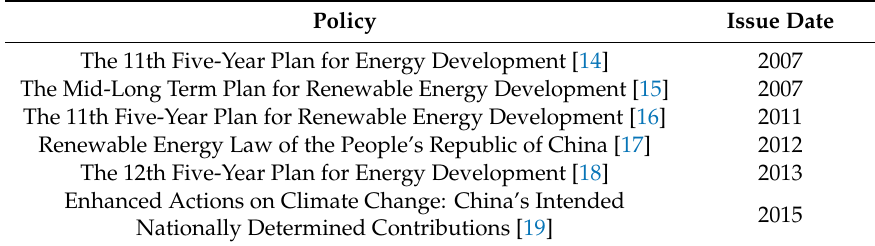
Table A1. China’s important energy policies during 2005-2015.